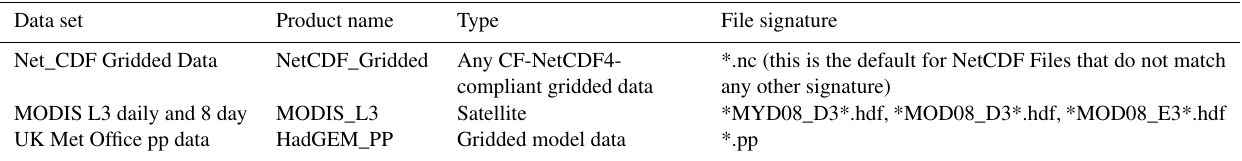
Table 2. A list of the gridded data sources supported by CIS 1.4.0. The file signature is used by CIS to automatically determine the correct product to use for reading a particular set of data files. This can always be overridden by the